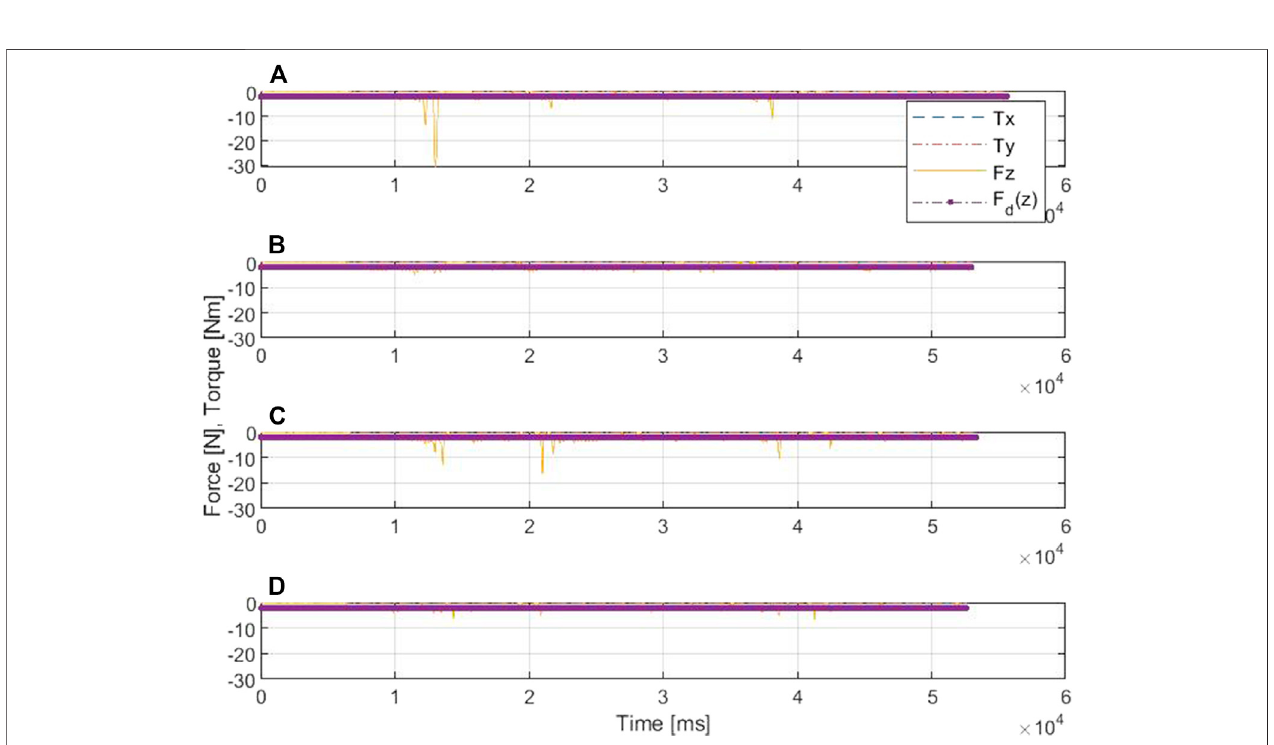
FIGURE 11 | Comparative results of the force/torque measurements in scenario II: (A) is for AC, (B) is for DAC, (C) is for SAC, and (D) is for SDAAC.